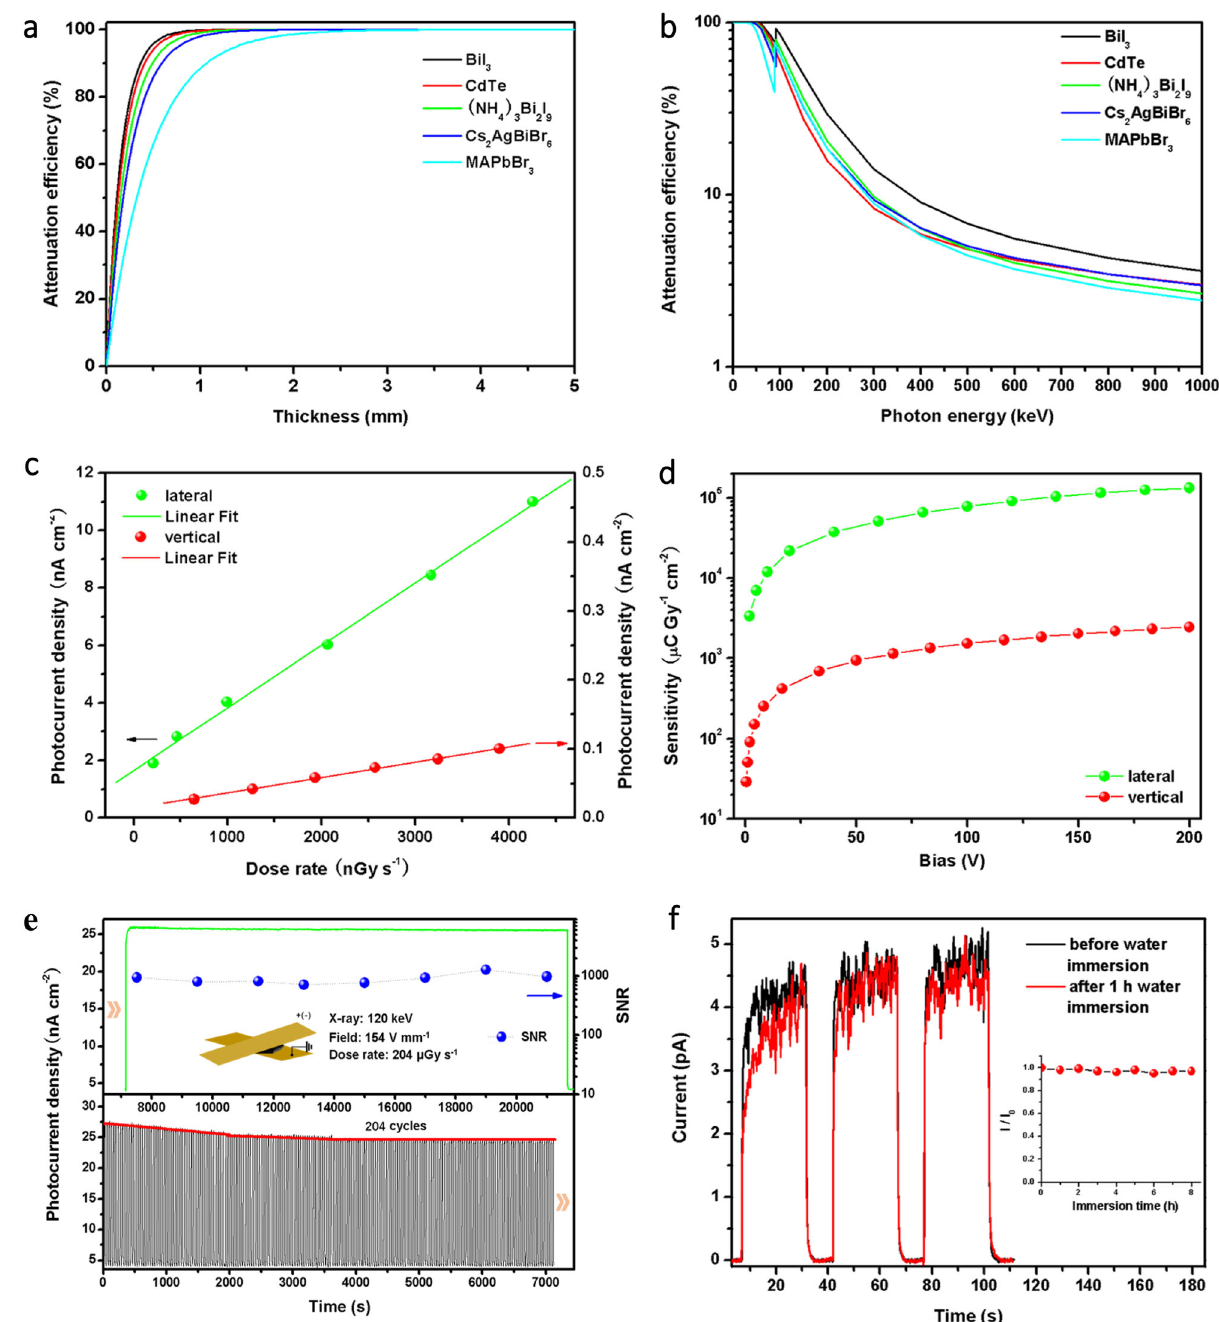
Fig. 5 | X-ray attenuation, sensitivity, and stability of Bi x I y detector at room temperature.a , b Attenuationef fi cienciesofBiI 3 ,(NH 4 ) 3 Bi 2 I 9 ,Cs 2 AgBiBr 6 ,MAPbBr 3 andCdTesemiconductorsversusthicknessto50keVX-rayphotons( a )andphoton energy( b ).ThecurveswerecalculatedbyemployingtheNISTXCOMphotoncross- section database 43 . c Anisotropic X-ray photocurrent densities at different dose rates measured by cavity-edge con fi guration under 1Vmm − 1 bias, the linear fi ttings (solid lines) are used to calculate the sensitivity. d Anisotropic X-ray sensitivities at different bias measured by cavity-edge con fi guration. e Device stability under repeated and continuous X-ray radiation. The black line is 204 repeated on/off response, followed by a response (green line) with a long continuous “ on ” time.